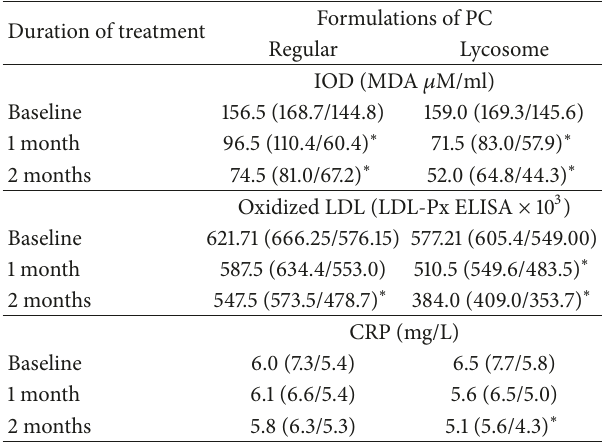
Table 4: Inflammatory oxidative damage (IOD) values, oxidized LDL, and C-reactive protein (CRP) levels after treatment with regular and lycosome formulations of PC (medians with 95/5%%